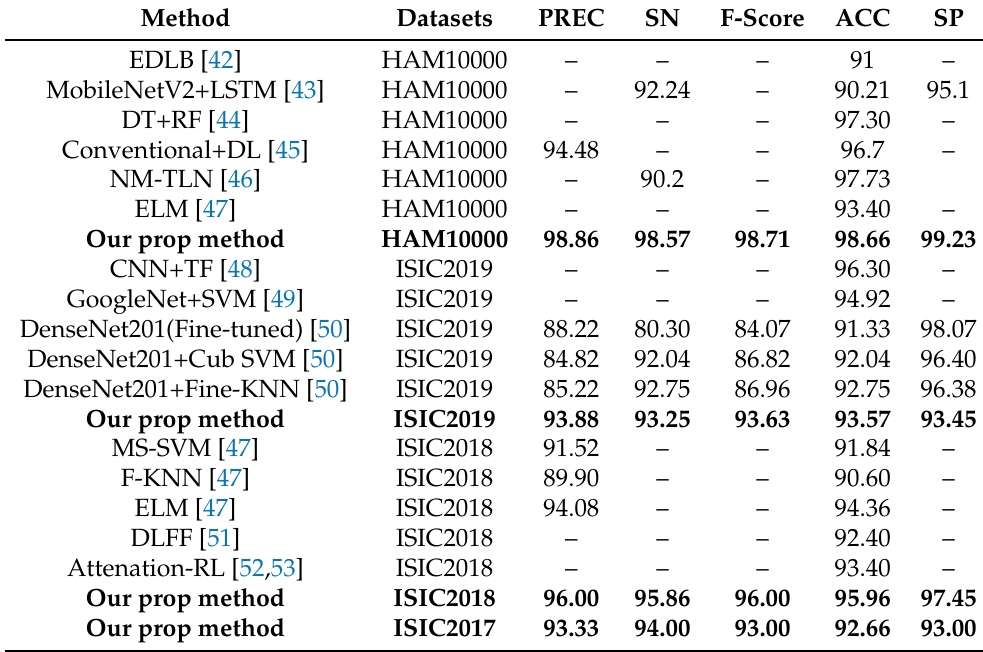
Table 7. Comparison of our method with other state-of-the-art methods in skin lesion recognition